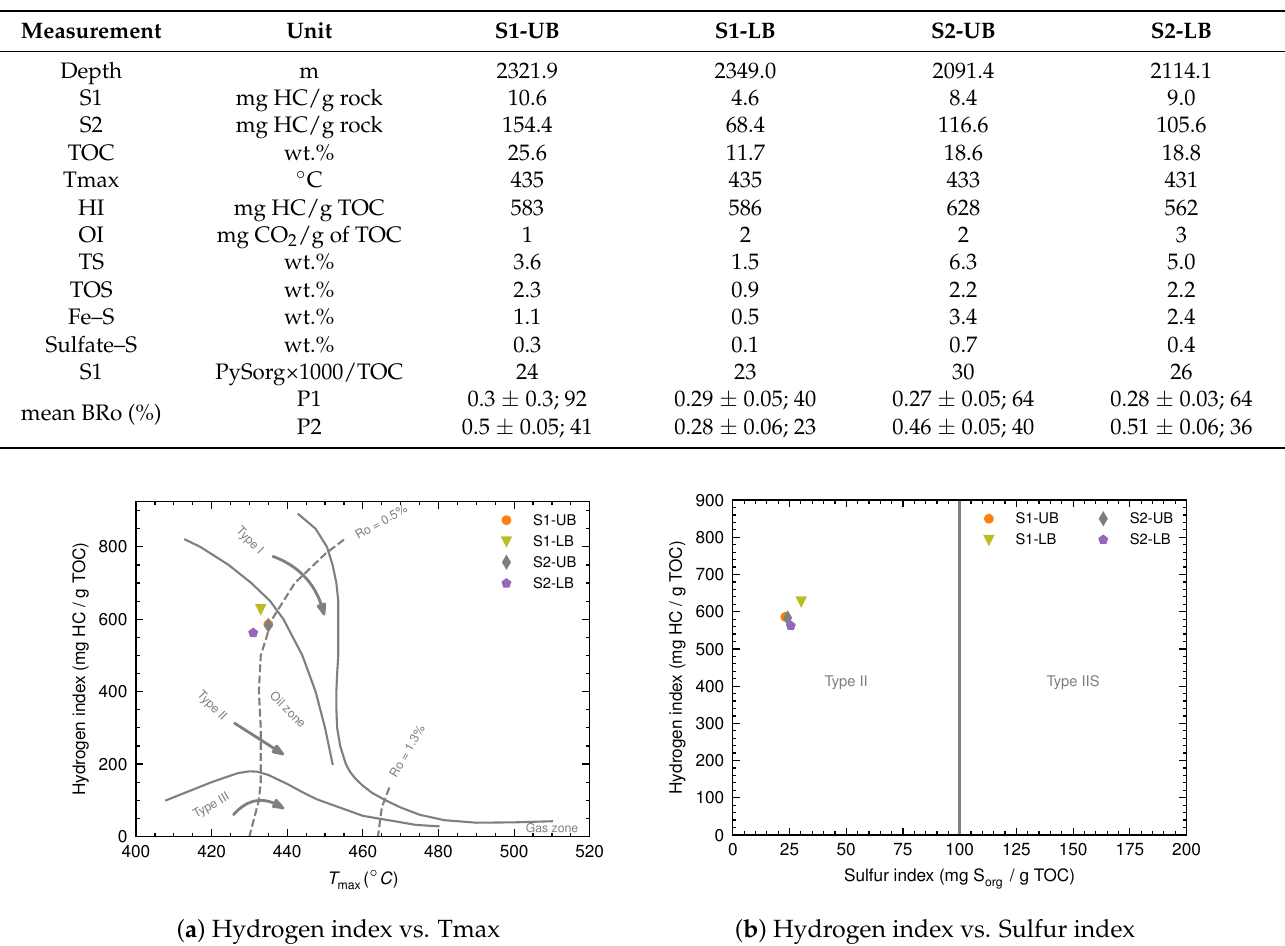
Table 1. The programmed pyrolysis data.